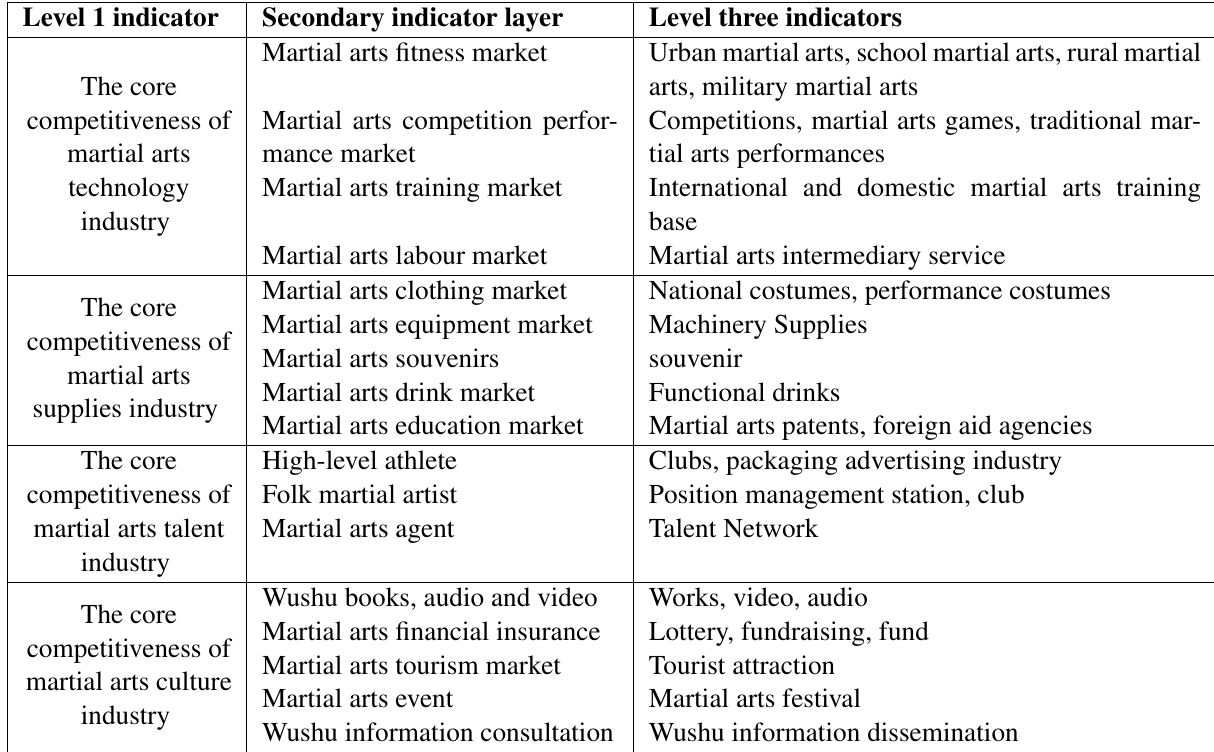
Table 1 The core competitiveness index system of the martial arts